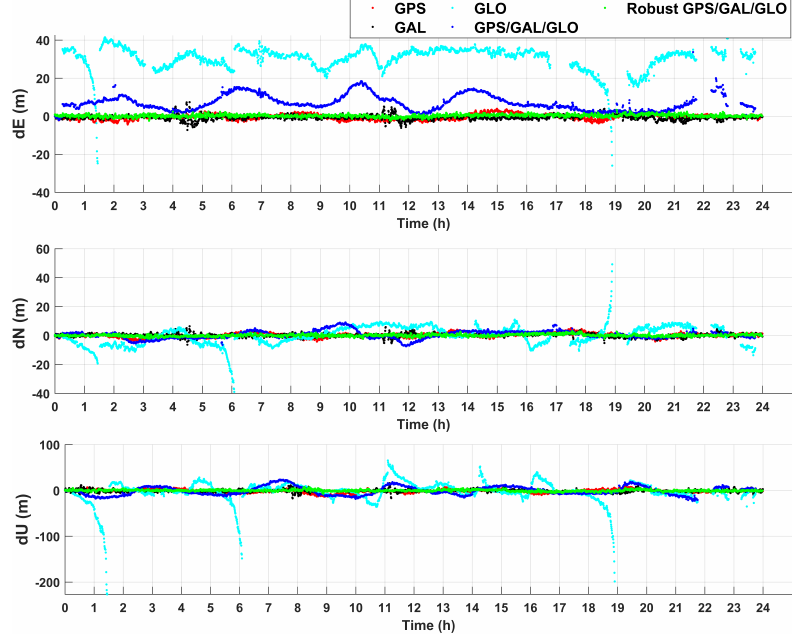
Figure 3. Position errors of the five scenarios at station ABMF.